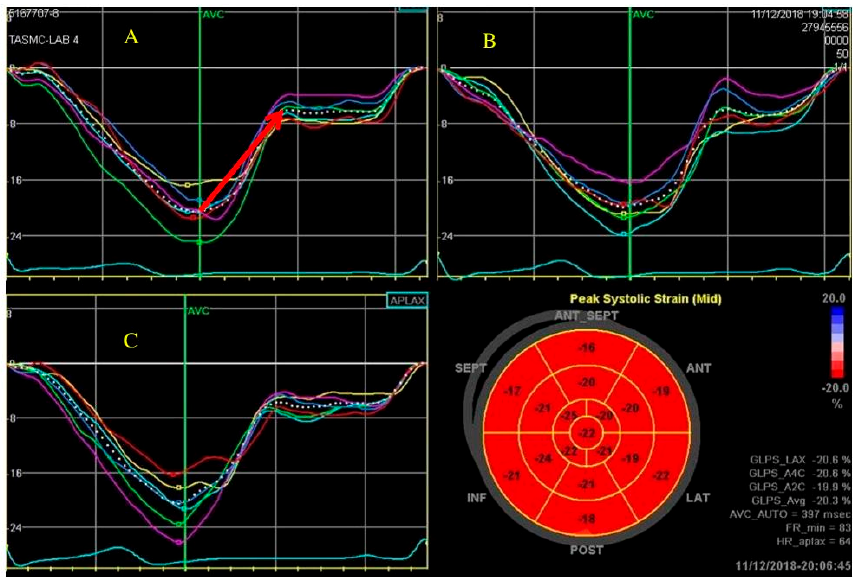
Figure 2. Diastolic strain time (Dst) measurement. Dst was evaluated by measuring manually the time of lengthening (ms) of the myocardium during diastole, from the point of aortic valve closure (AVC) throughout the isovolumic relaxation time and early diastolic, until the plateau of the curve. Dst was assessed in three apical views, 4 chamber ( A ), 2 chamber ( B ) and 3 chamber ( C ) views, with 6 segments measured per each view (presented in the different colors), with a total of 18 segments per each exam. The red arrow shows how the measurement was performed manually for the average of the 6 segments in the 4-chamber view.